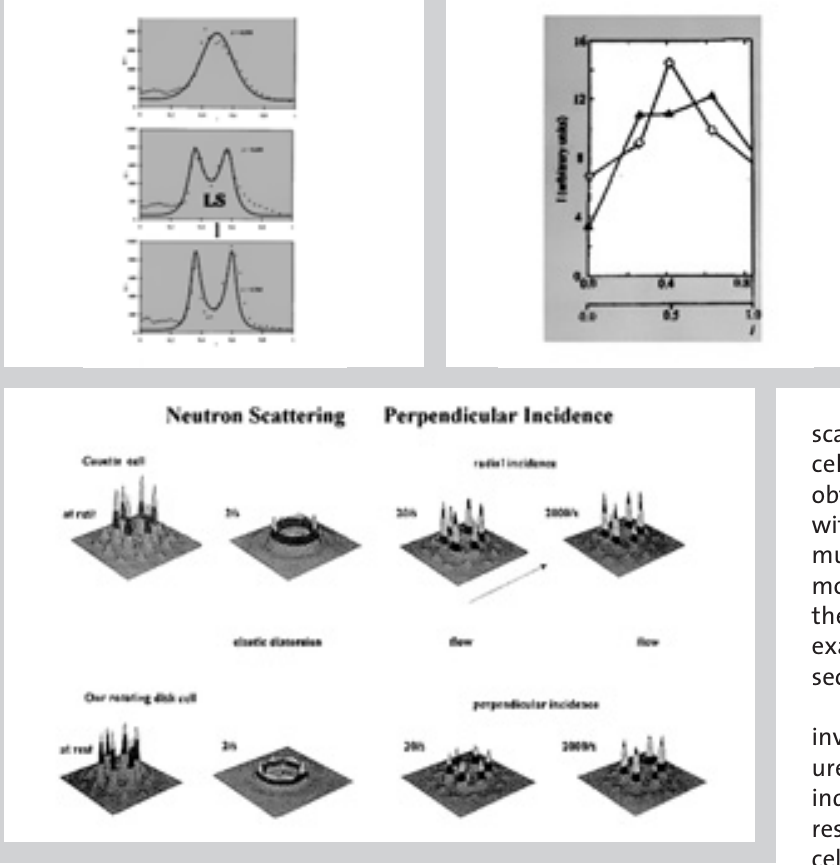
Figure 7 (above): LS, SANS, and SAXS l-depen- dence of the scattering intensity along h, k rods. Figure 8: Neutron scattering (SANS) of the viscoelastic transi-